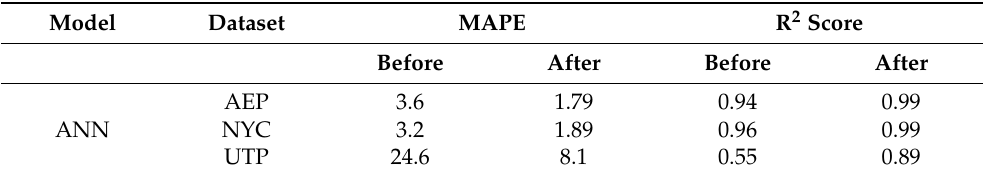
Table 4. ANN model performance on A.E.P., N.Y.C., and U.T.P. datasets before and after parametric